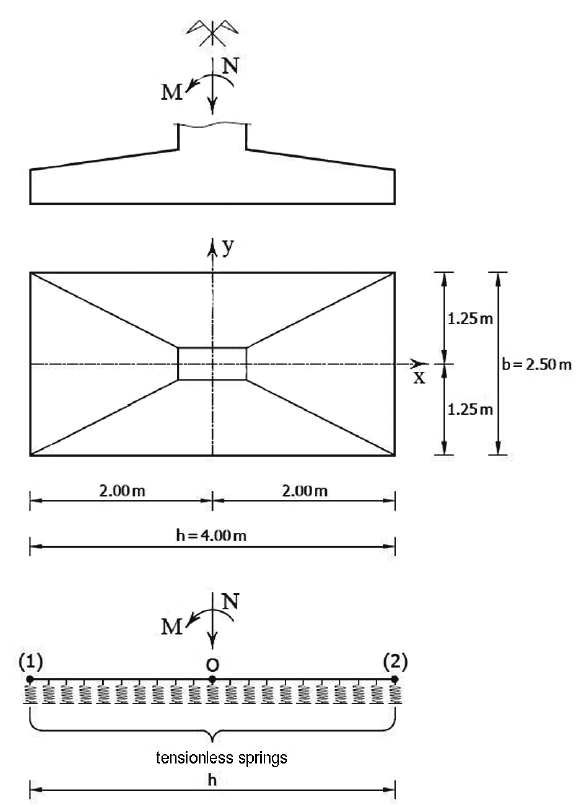
Fig. 9. Dimensions of rigid rectangular footing (Example 3.2)